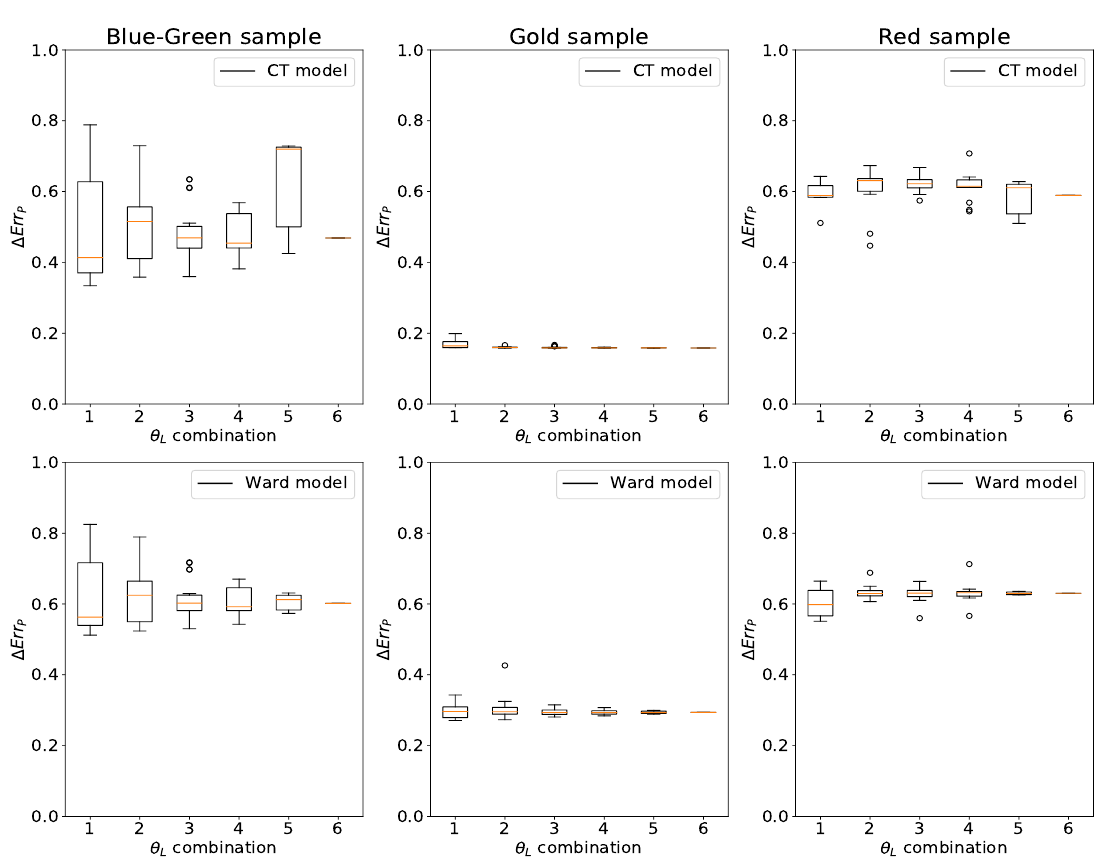
Figure 7. Box-and-whisker plots showing ∆ Err P between G-channel camera RGB data calculated from GCMS measurements and data estimated using both models of all the samples. The orange line in the boxes shows the median error value obtained between the θ L combinations used for model fitting. Circle dots are large ∆ Err P error obtained (approximately three-times the range of error variation (boxes) obtained). CT,